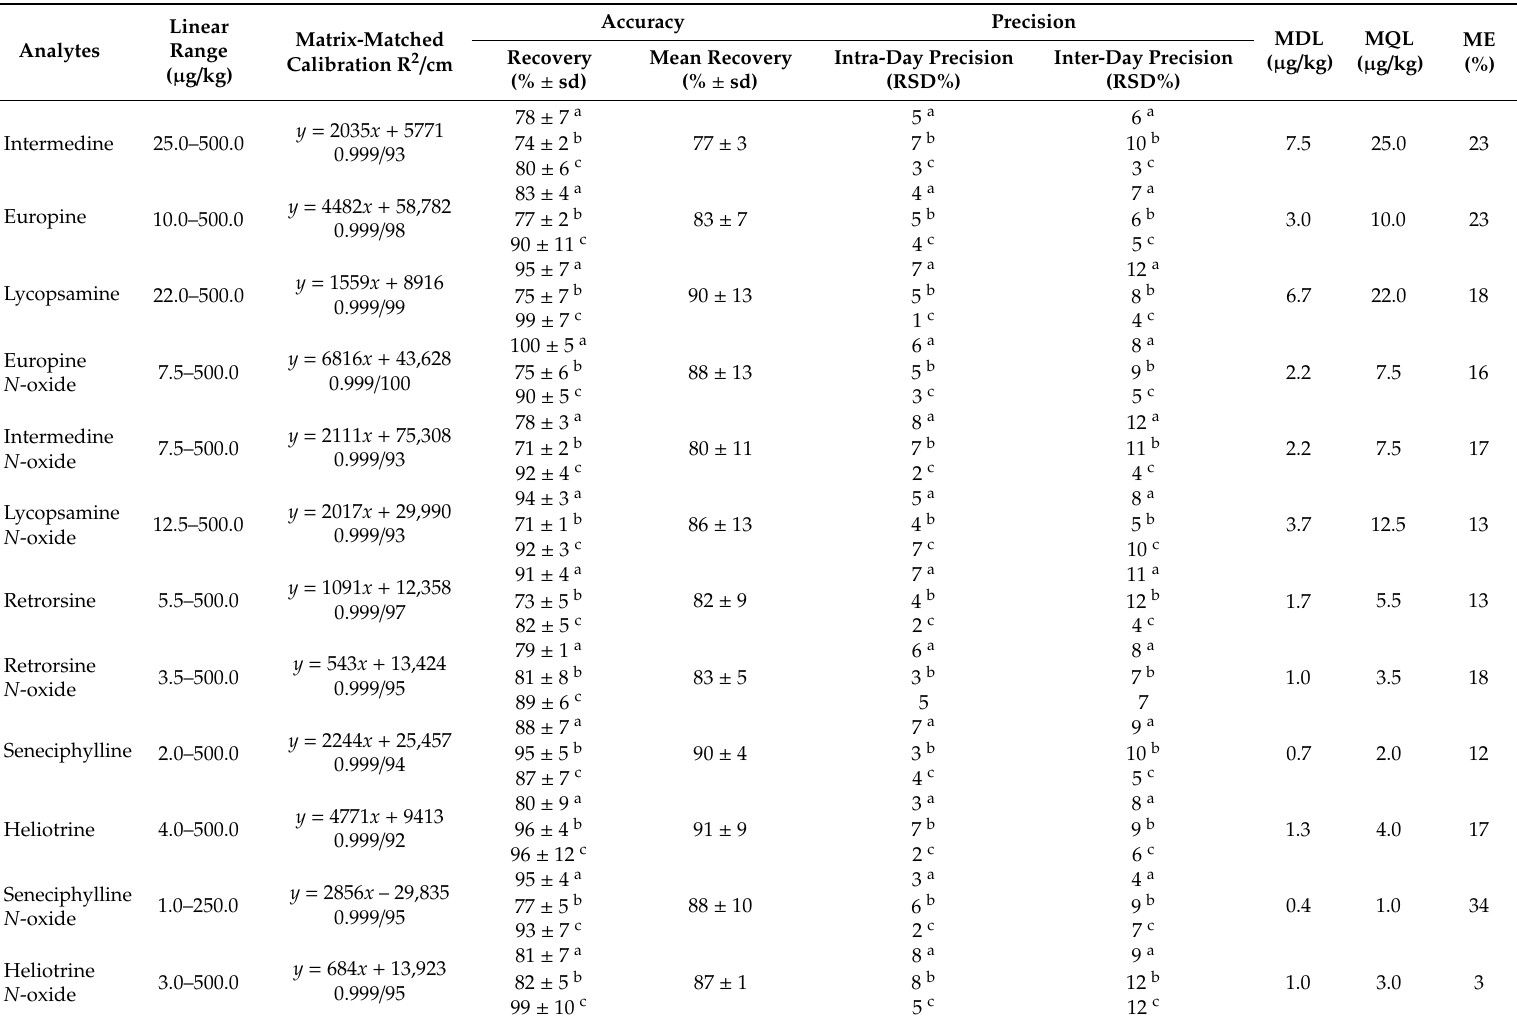
Table 2. Validation parameters of the µ -QuEChERS method for the determination of the target PAs / PANOs in oregano